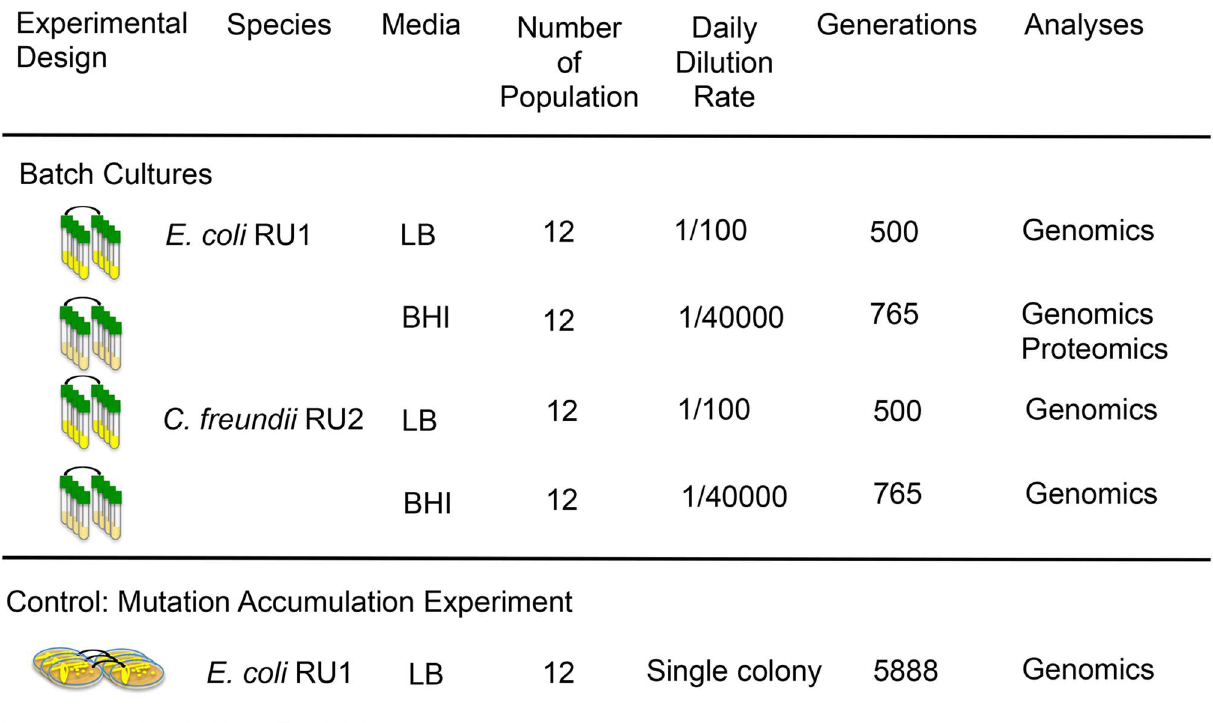
Fig. 1. Population genomics and population proteomics were used to identify the biochemical basis for phenotypic convergence and parallel evolution during adaptation to novel resource rich environments. Clones of two species, E. coli RU1 and C. freundii RU2, were isolated de novo from human stool. Single clones were used to inoculate twelve replicated populations and evolved in LB or BHI for 500 or 765 generations respectively by daily transfers into fresh media. Adaptive mutations were identified as mutations that evolved repeatedly across species and media. We performed a mutation accumulation experiment by transferring a single colony of twelve replicated lines for 200 days as control experiment. The relaxed selection allowed the random accumulation of mutations, and makes the parallel evolution of adaptive mutations